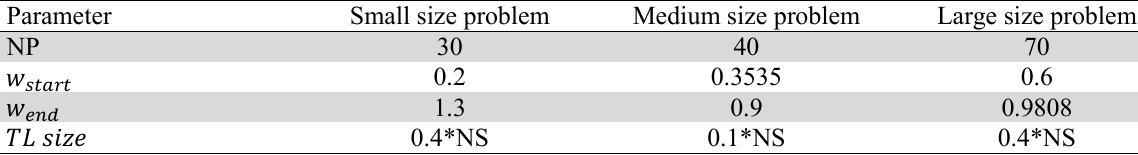
Tuned value of PSOa’s parameters Parameter